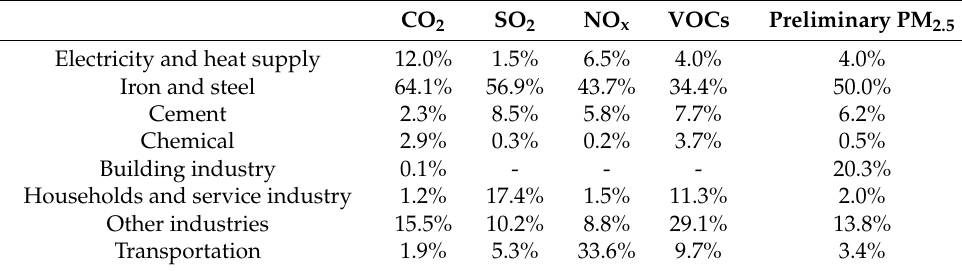
Table A1. The sectoral contribution of CO 2 and air pollutant emissions of Tangshan in